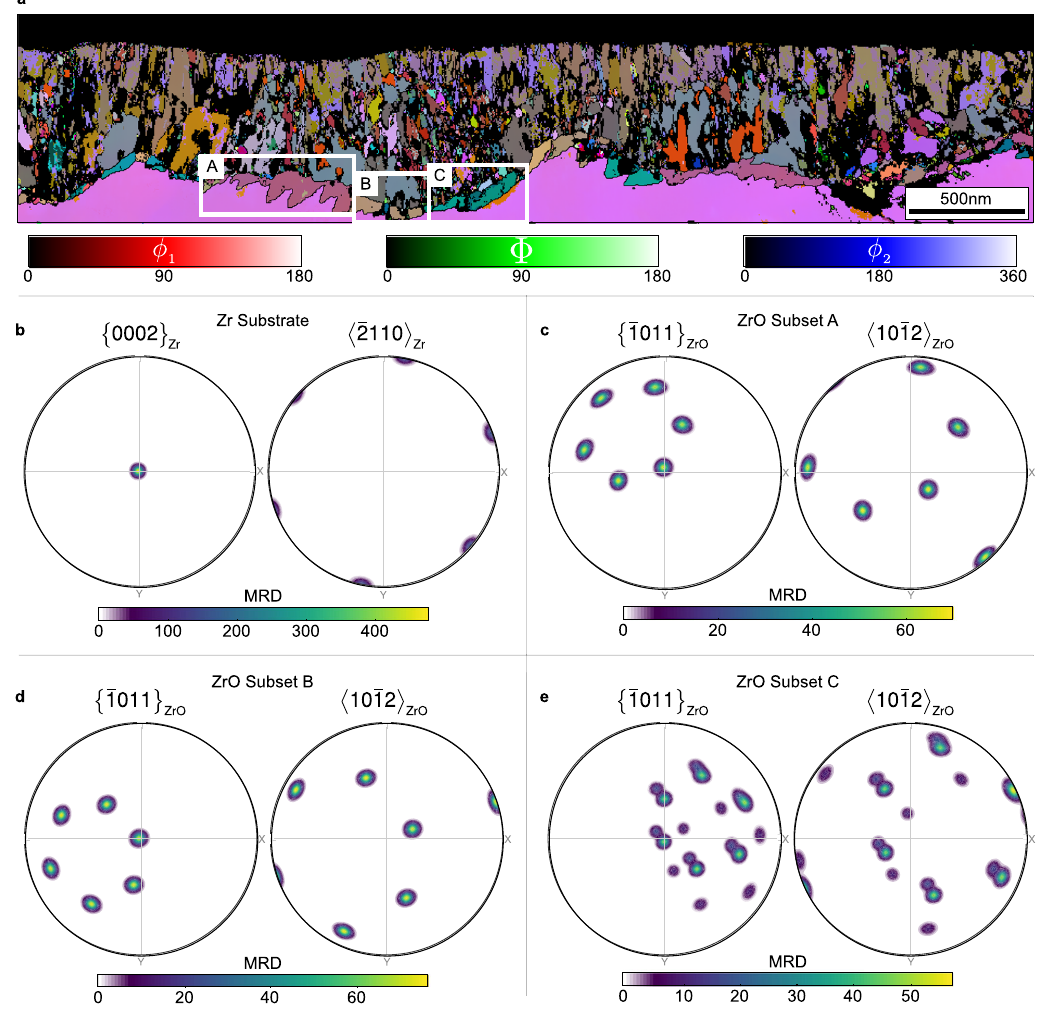
f (cid:1) 1011 g and h 10 (cid:1) 12 i pole fi guresfortheZrOsub-oxidesubsetsA,BandClabelledin a . The f 0002 g Zr is aligned parallel to the pole fi gure z direction to make orientation relationships clearer. Colours represent intensity in units of MRD (multiples of a random